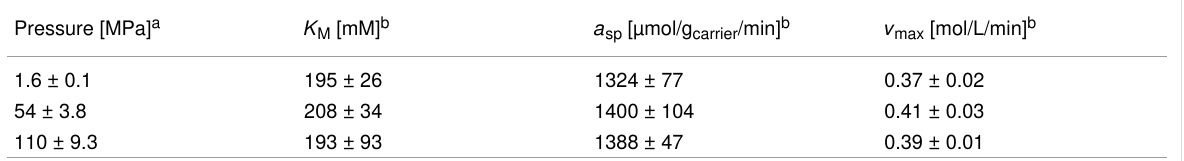
Table 3: Kinetic parameters from experiments with immobilized epimerase.